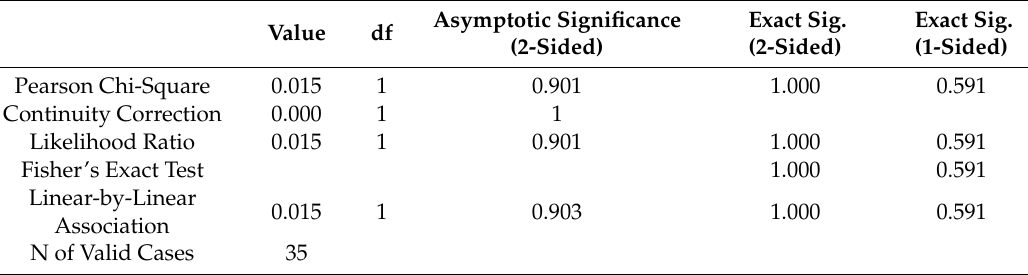
Table 8. The chi-square test for using a reference